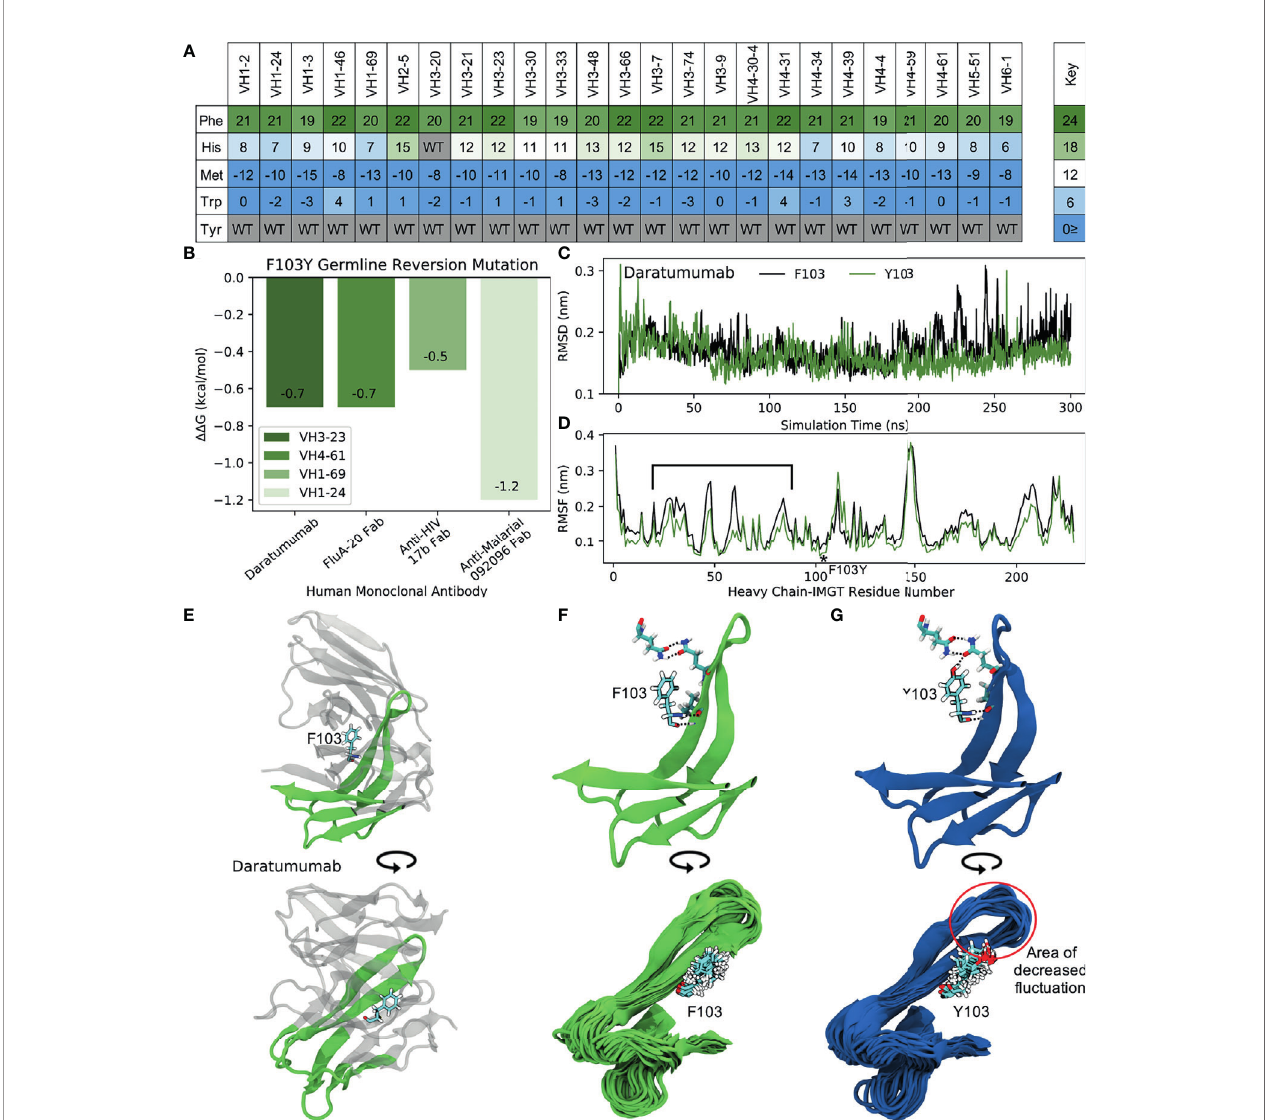
FIGURE 8 | MD simulations indicate the ‘ universal ’ FR mutation Y103F decreases mAb stability. (A) Heatmap of FR scores for the mutation of residue 103 to different amino acids for each of the 25 germline genes. (B) Change in stability as predicted by PremPS upon introducing the F103Y germline-reverted mutation into the sequence of Daratumumab and three other human mAbs found to have the F103Y mutation. (C) Root mean square deviation (RMSD) of Daratumumab with and without the germline-reverted mutation F103Y as a function of MD simulation time. (D) Root mean square fl uctuation (RMSF) of individual residues in Daratumumab with and without the F103Y mutation. (E) Energy-minimized structure of Daratumumab in white with highly fl uctuating regions in green, as indicated in (D) by square brackets. (F) Zoomed-in view of region-of-interest from panels (D, E) , highlighting the reduced hydrogen bonding capabilities of F103 in Daratumumab (top), leading to increased fl uctuations in surrounding loop regions (bottom). (G) MD simulation snapshot of Daratumumab with the F103Y mutation, highlighting the strong hydrogen bonding capacity of Y103 (top), leading to reduced fl uctuations in surrounding loops